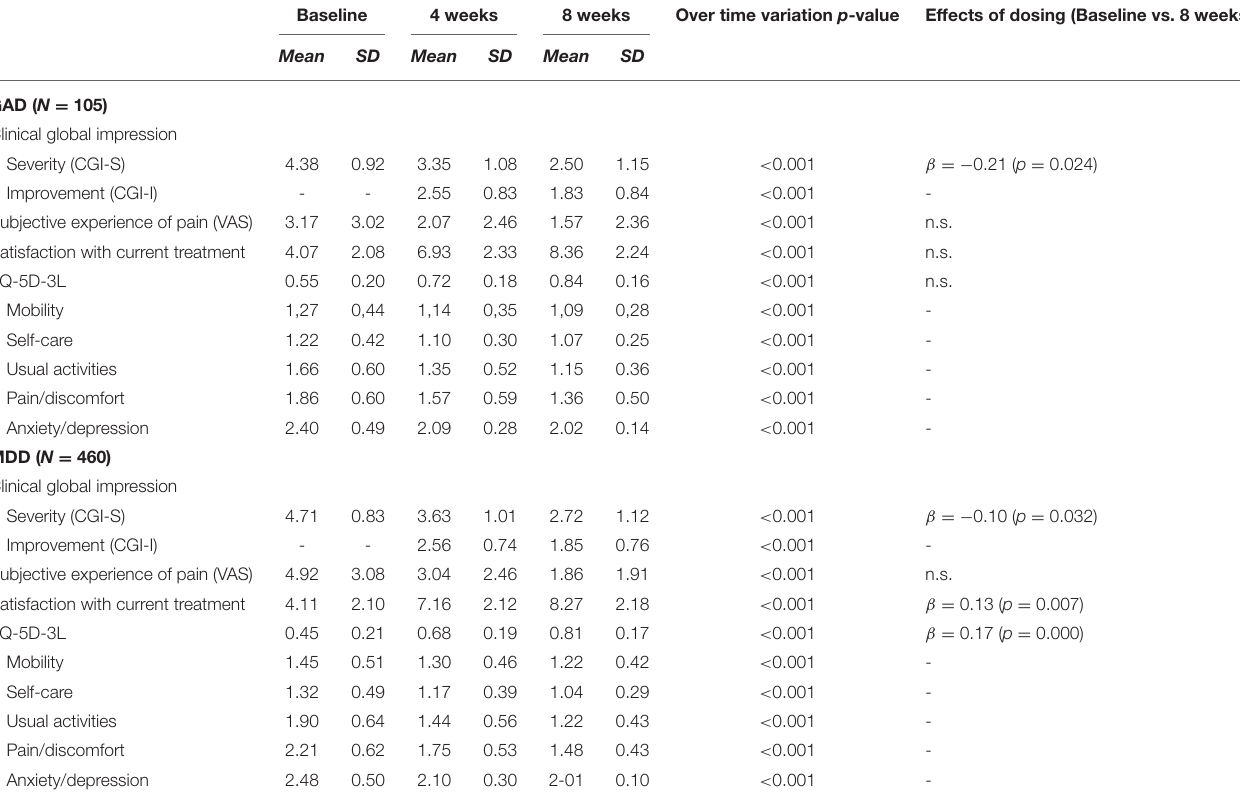
TABLE 3 | Outcome measures for patients treated with duloxetine and effects of dosing. Baseline 4 weeks 8 weeks Over time variation p -value Effects of dosing (Baseline vs. 8 weeks) Mean SD Mean SD Mean